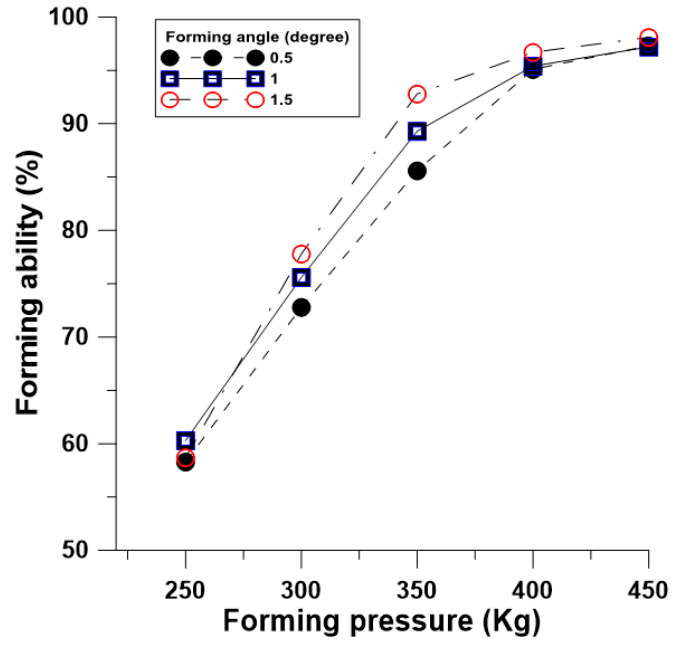
Figure 16. Influence of unequal roller embossing pressure on the accuracy of the special forming angle.